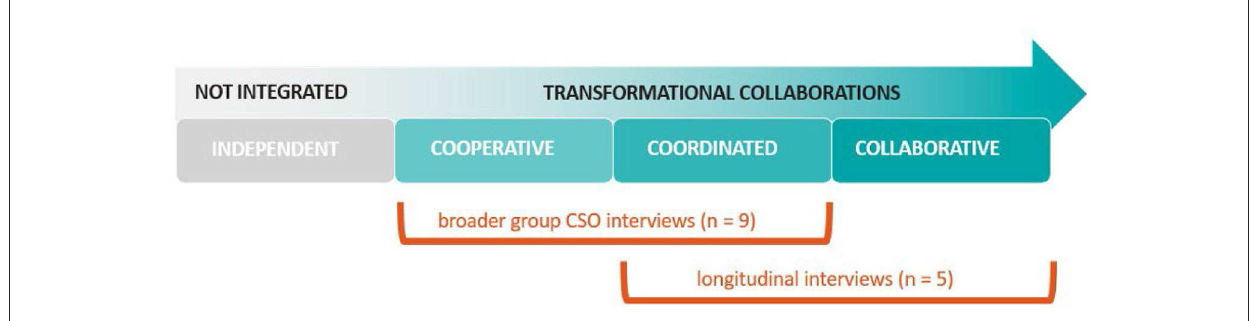
FIGURE2 CSO interviewees involved in WASH and GESI partnerships identifying where their partnerships sit against a spectrum, adapted from Winterford (2017) and based on the work of Moore and Skinner (2010).